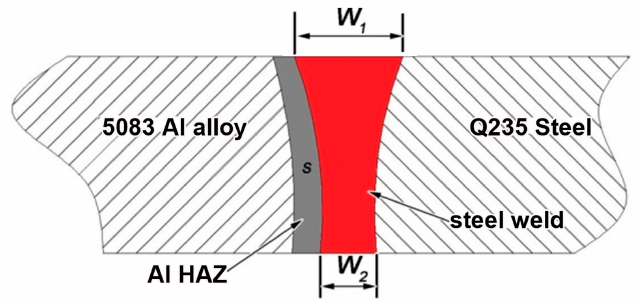
Figure 2. Diagram of dimensions of the weld cross section in the Al/steel butt joints.